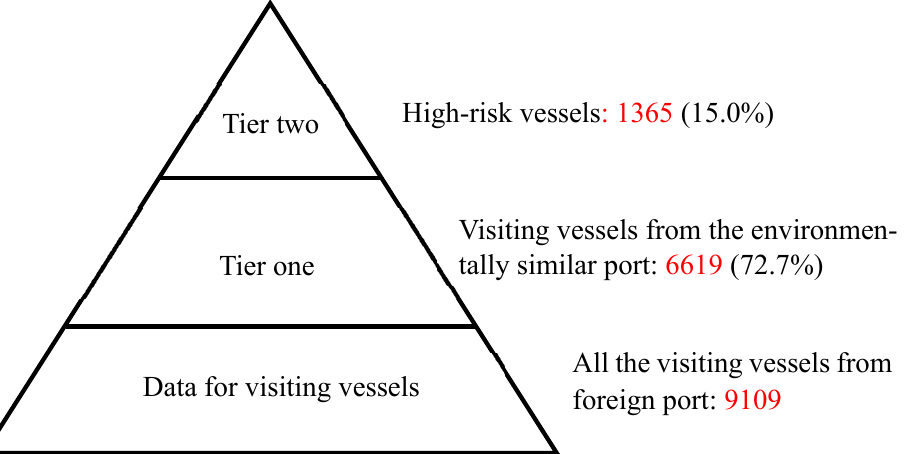
Figure 2. The results of the two-tier risk analysis performed for the incoming vessels to the port of